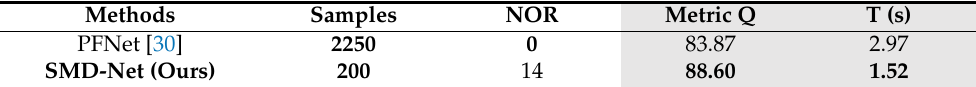
Figure 12. The filtered results obtained by processing area A and area B: ( a ) Filtered result of area A utilizing the PFNet trained with 2250 training samples; ( b ) the filtered result of area A utilizing the proposed method trained with 200 training samples; ( c ) the filtered result of area B utilizing the PFNet trained with 2250 training samples; ( d ) the filtered result of area B utilizing the proposed method trained with 200 training samples. Table 5. The metrics of the PFNet trained with 2250 samples and the SMD-Net trained with 200 sam- ples on area A. Metric Q is the core accuracy index. T is the speed index.